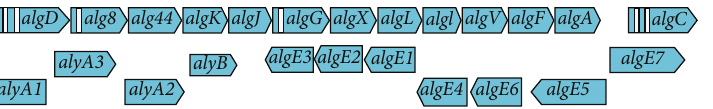
Figure 4: Genetic structure genes involved in alginate biosynthesis and modification in Azotobacter vinelandii . Gene operon for alginate biosynthesis algD-A , and algC gene is transcribed separately; alyA1 – 3 and alyB alginate lyases encoding genes, and algE1 – 7 the epimerases genes.